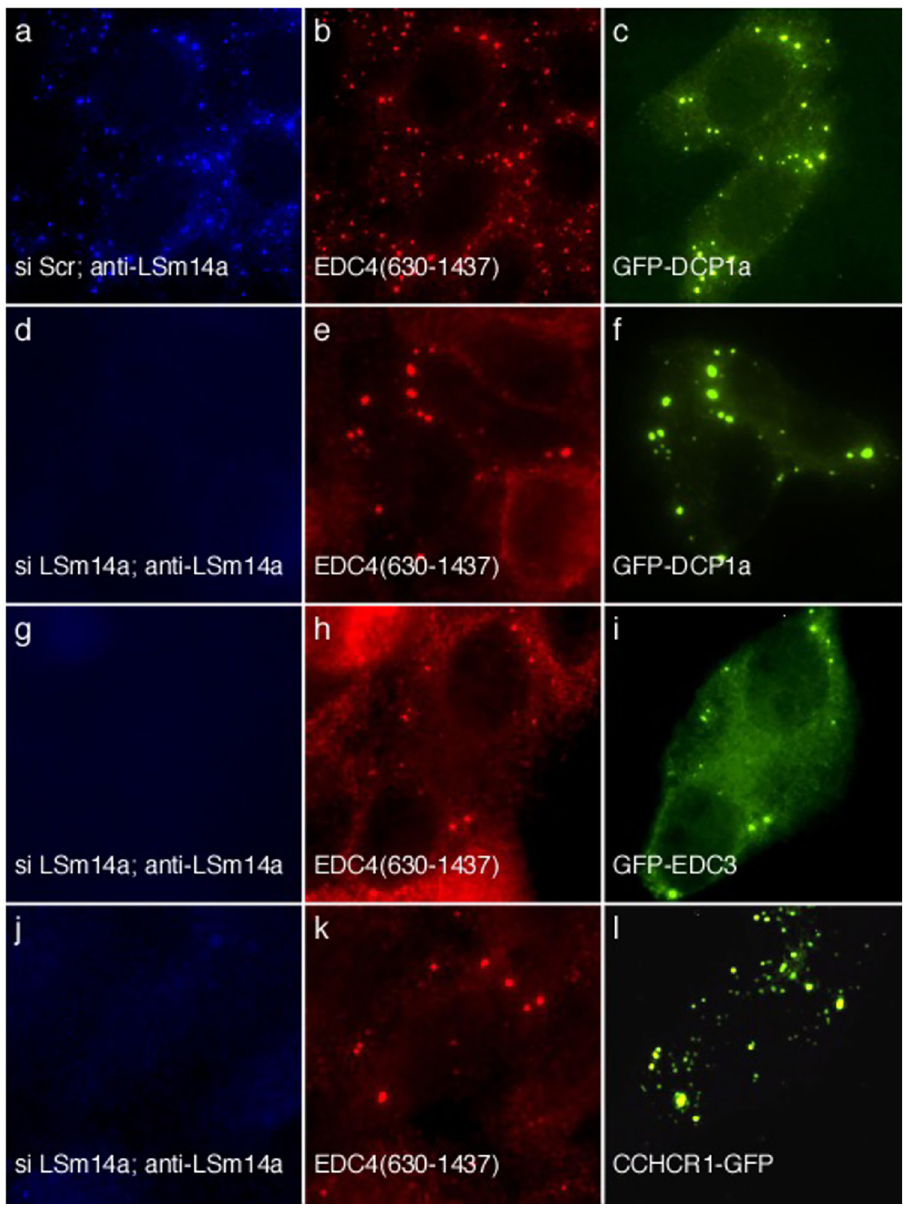
Fig 8. EDC4(630–1437) can recruit DCP1a, EDC3 or CCHCR1 to cytoplasmic dots despite depletion of LSm14a and loss of endogenous P-bodes. After treatment with scrambled siRNA, LSm14a (panel a), EDC4(630–1437) (panel b) and GFP-DCP1a (panel c) all localized in cytoplasmic dots. siRNA directed against LSm14a resulting in depletion of LSM14a from HEp-2 cells (panel d), but EDC4(630–1437) (panel e) and GFP-DCP1a (panel f) localized to cytoplasmic dots. Depletion of LSm14a (panels g, j) did not affect localization of EDC4(630–1437) (panels h, k) and EDC3 (panel i) or CCHCR1 (panel l) to cytoplasmic dots. Rabbit antiserum was used to detect LSm14a in panel a and to confirm the absence of LSm14a and endogenous P-bodies in d, g, and j. Human serum reacted with EDC4(630–1437) in b, e, h and k. Mouse anti-GFP antibody detected GFP-DCP1a in c and f, GFP-EDC3 in i, and CCHCR1-GFP in l. https://doi.org/10.1371/journal.pone.0282496.g008 fraction of cellular PATL1 has a nuclear distribution that is similar to that of NLS-EDC4: local- ization to Cajal bodies and adjacent to a subset of PML nuclear bodies [29, 30]. In this study, NLS-EDC4 appeared to determine the location of nuclear PATL1, because when NLS-EDC4